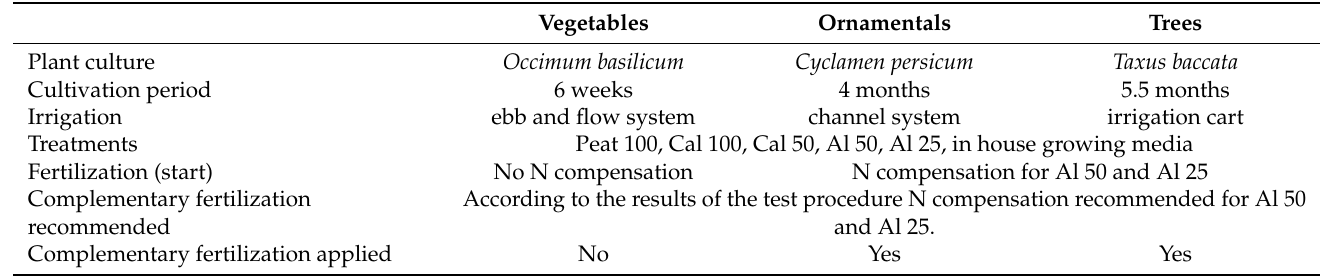
Table A3. General setup of the experiments under practical conditions with the potential new substrate components [13]. Explanation of treatment names see Table